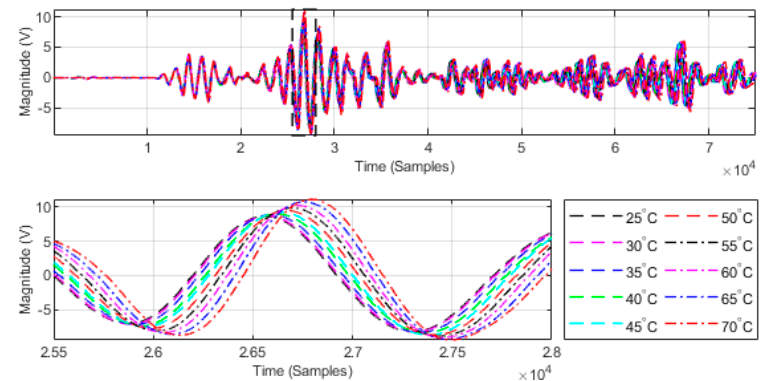
Figure 3. Received signals of the 10th transmitter and receiver transducers at various temperatures in the range from 25 °C to 70 °C.